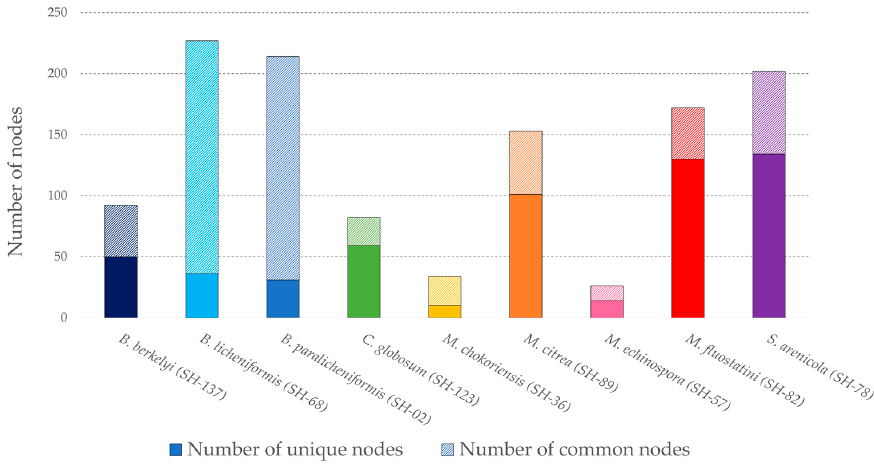
Figure 2. Histogram representing the number of unique (plain pattern) and common (striped patterns) nodes for each strain.